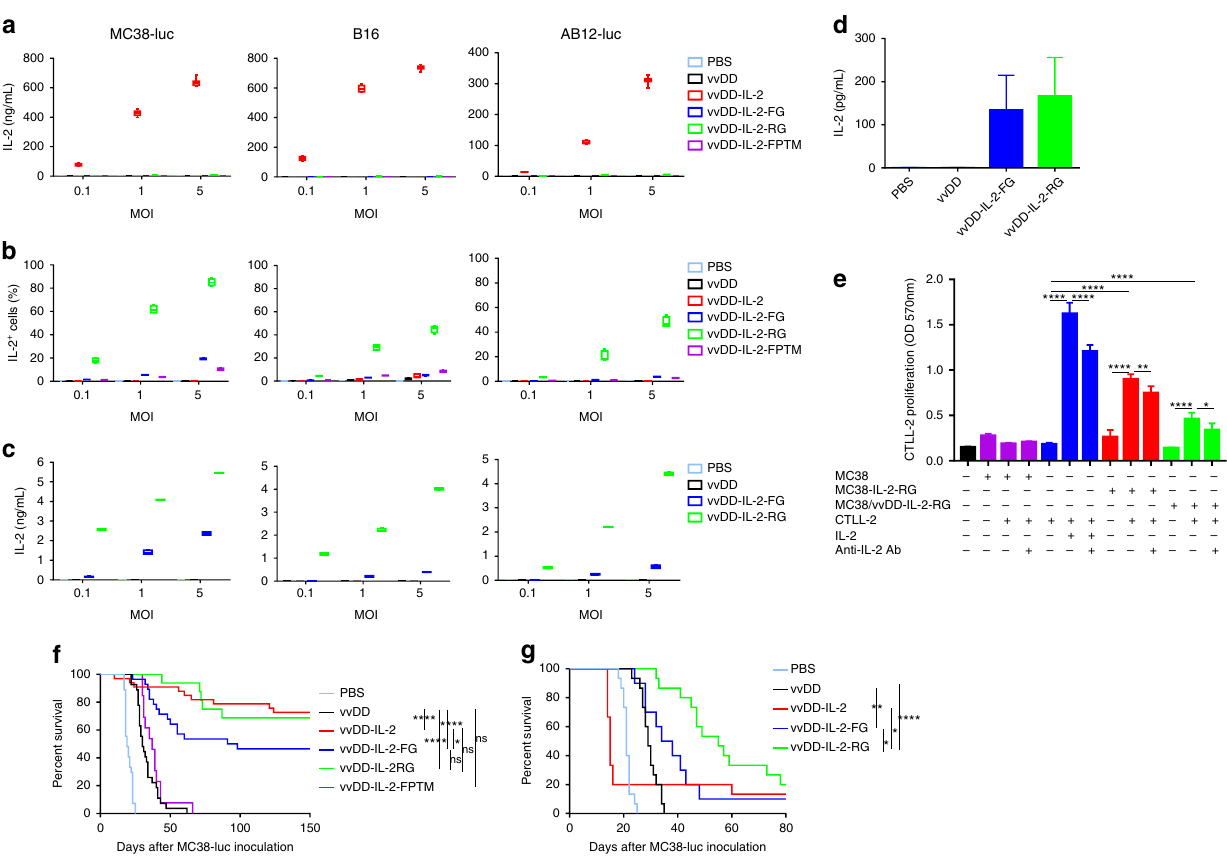
Fig. 1 Expression of IL-2 variants and their antitumour effects. Tumour cell MC38-luc (3 × 10 5 cells), B16 (2 × 10 5 cells), or AB12-luc (3 × 10 5 cells) were mock-infected or infected with vvDD, vvDD-IL-2, vvDD-IL-2-FG, vvDD-IL-2-RG, or vvDD-IL-2-FPTM at a MOIs of 0.1, 1, and 5. The culture supernatants were harvested to measure secreted IL-2 by ELISA ( a ) and the cell pellets were harvested to measure membrane-bound IL-2 either by by fl ow cytometry (cell surface staining) ( b ) or by ELISA after PI-PLC cleavage ( c ) 24 h post-infection. B6 mice were i.p. inoculated with 5 × 10 5 MC38-luc cells and treated with PBS ( n = 5), vvDD ( n = 5), vvDD-IL-2-FG ( n = 5), or vvDD-IL-2-RG ( n = 6) at 2 × 10 8 PFU per mouse 5 days post-tumour inoculation and GPI- anchored IL-2 was measured by ELISA post PI-PLC cleavage from single cells of tumour mass 5 days after treatment (2 × 10 6 cells were incubated with antibody ( e ). Data are representative of two independent experiments. B6 mice were i.p inoculated with 5 × 10 5 MC38-luc cells and treated with PBS ( n